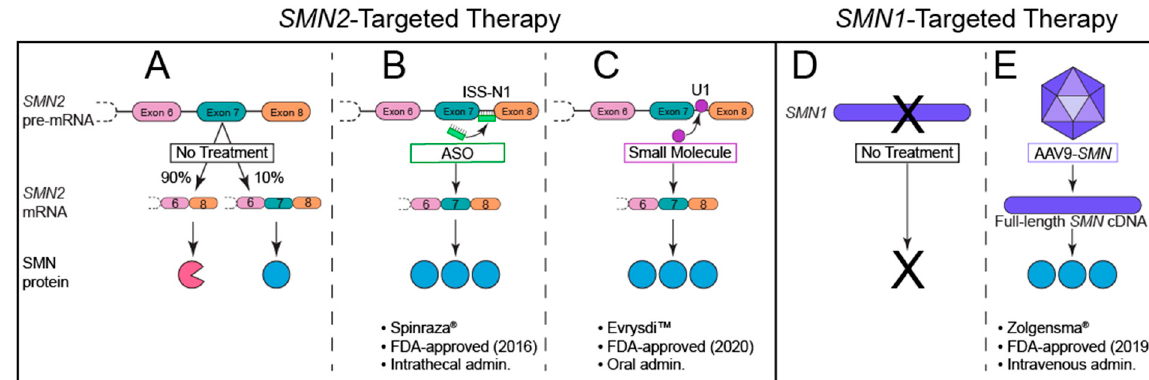
Figure 4. FDA ‐ approved SMN ‐ based therapies for SMA. ( A ). In the absence of therapeutic intervention, the SMN2 gene produces predominantly truncated SMN protein (pink incomplete circle) and only a small percentage of full ‐ length SMN protein (blue full circle) due to poor inclusion of exon 7 in mature mRNA transcripts. ( B ). The first FDA ‐ approved therapy for SMA utilizes antisense oligonucleotides (ASOs; green icon; brand name Spinraza ® ) to target intronic splicing silencer N1 (ISS ‐ N1), thereby increasing inclusion of exon 7 in mature mRNA transcripts. ( C ). The most recent FDA ‐ approved therapy, risdiplam (purple circle; brand name Evrysdi™), enhances U1 ‐ pre ‐ mRNA association to promote inclusion of exon 7 in mature mRNA transcripts. ( D ). SMA is caused by homozygous loss of functional SMN1 (by gene deletion or conversion), resulting in a lack of SMN protein derived from this gene. E. Onasemnogene ‐ xioi (brand name Zolgensma ® ) causes transduced cells to transcribe full ‐ length SMN cDNA.